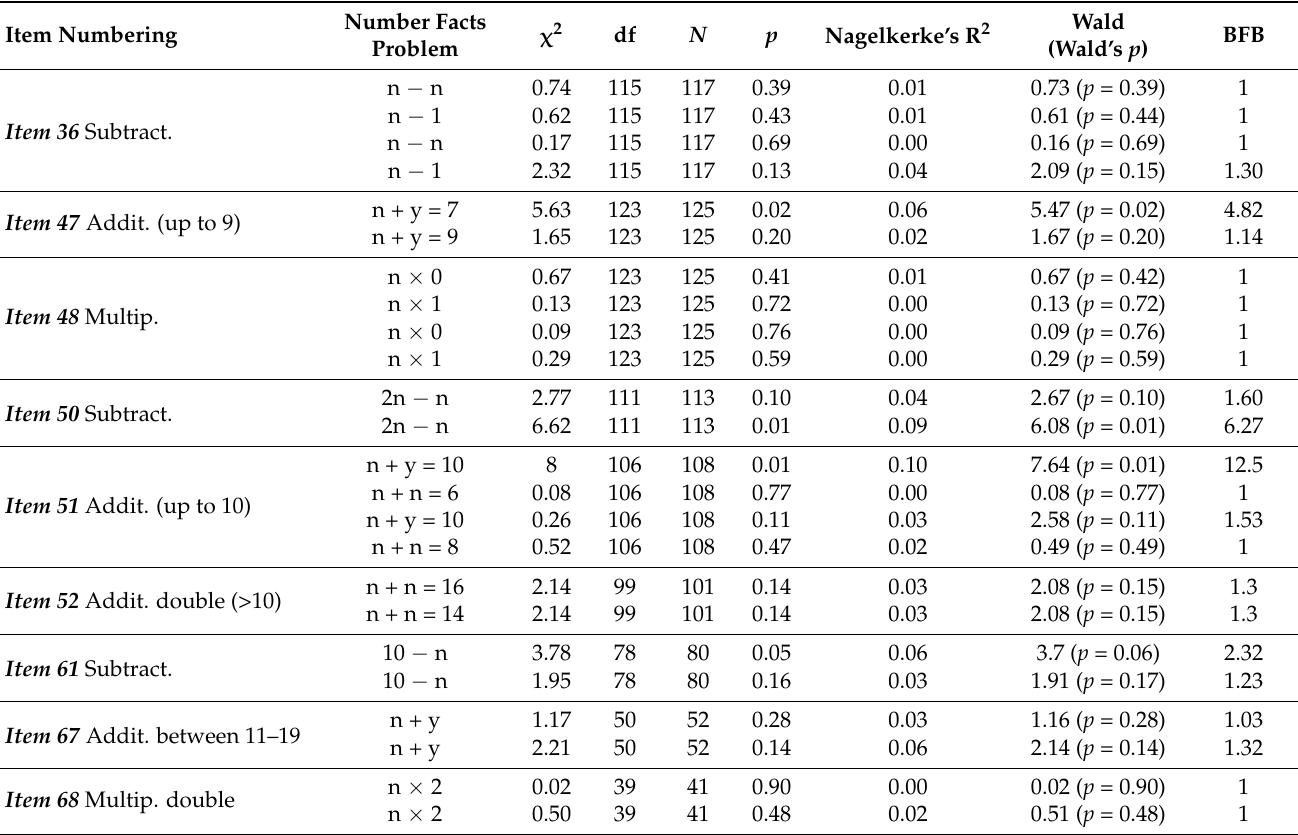
Table A1. Statistics for Gender (as categorial predictor) in binary logistic regression models. Each “Number Fact” problem was modeled